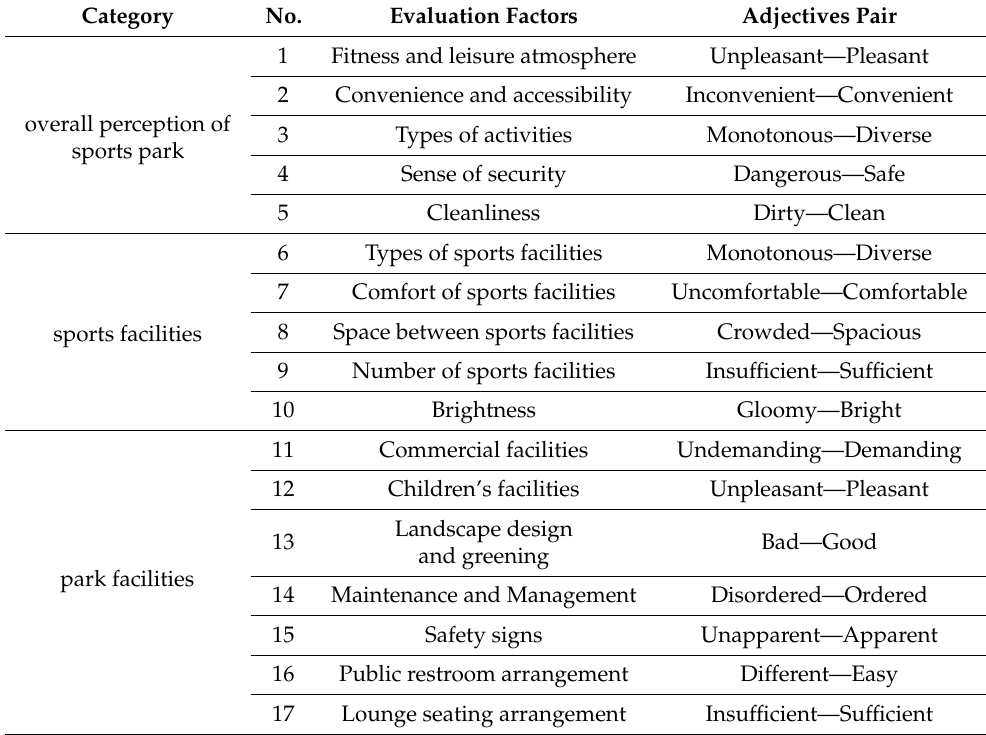
Table 2. Semantic evaluation factors.